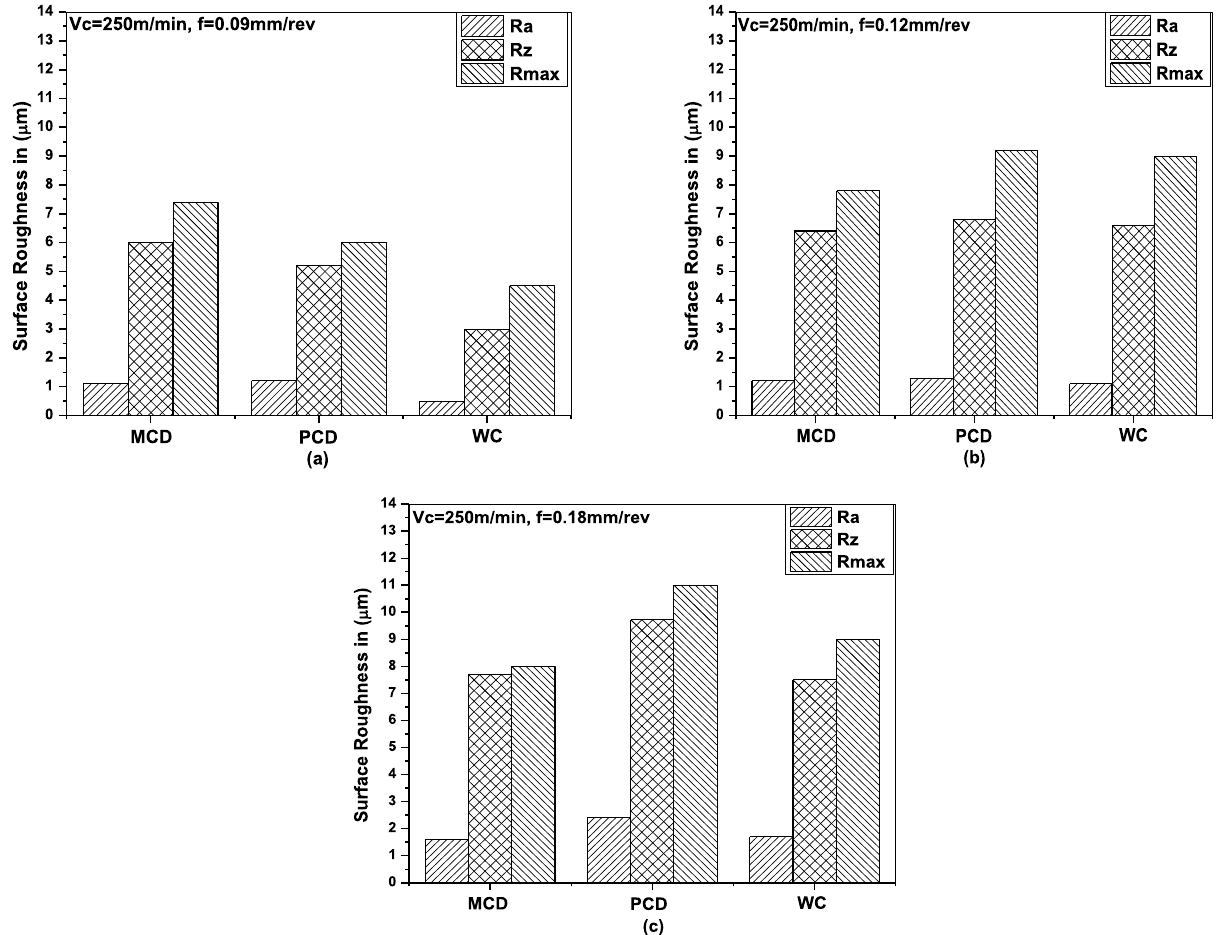
Fig. 17. Graph representing the roughness values ( Ra , Rz , R max ) for different tools at constant velocity of 250 m/min and varying feed, (a) Feed = 0.09mm/rev, (b) Feed =0.12 mm/rev and (c) Feed =0.18